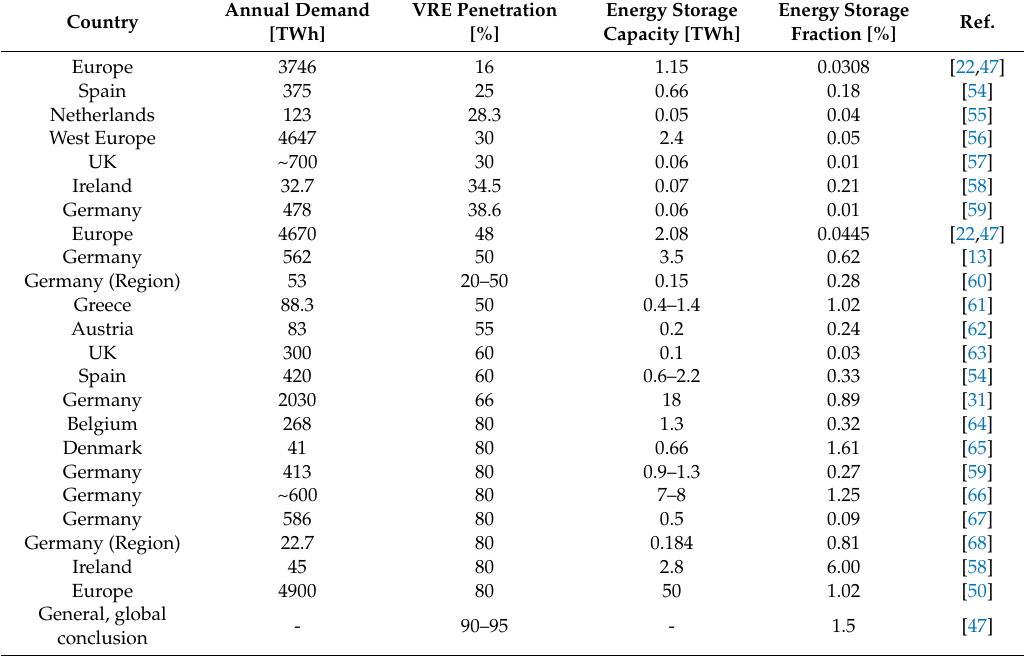
Table 4. Recommended annual storage features in Europe, with less than 100% VRE penetration, based on